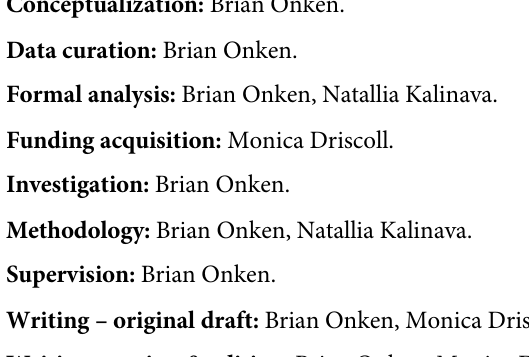
S5 Fig. Gluconeogenic gene fbp-1 expression is required for healthspan extension under dietary restriction. (A) Survival curves of long-lived, dietary-restricted eat-2(ad1116) mutants treated with RNAi against gluconeogenic gene fbp-1 . fbp-1 (RNAi) decreases median survival by 10% and shifts the survival curve to the left ( P < 0.0001, Log-rank). Data are pooled from 5 independent trials, n = 60 animals per condition per trial. (B) Survival curves of wild-type ani- mals raised under ad libitum (AL) or dietary restriction (DR) conditions, with and without fbp-1(RNAi) . Median survival of animals expressing the vector control was higher under DR conditions as compared to well-fed controls (an 18.62% increase, see S1 Table for details), and survival was increased ( P = 0.0039, Log-rank test). Disrupting gluconeogenic gene fbp-1 completely abolished these beneficial DR effects: animals raised on diluted gluconeogenic RNAi bacteria had survival curves that were not significantly (n.s., Log-rank) different from those of well-fed animals. Data are pooled from 2 independent trials, n = 60 animals per condi- tion per